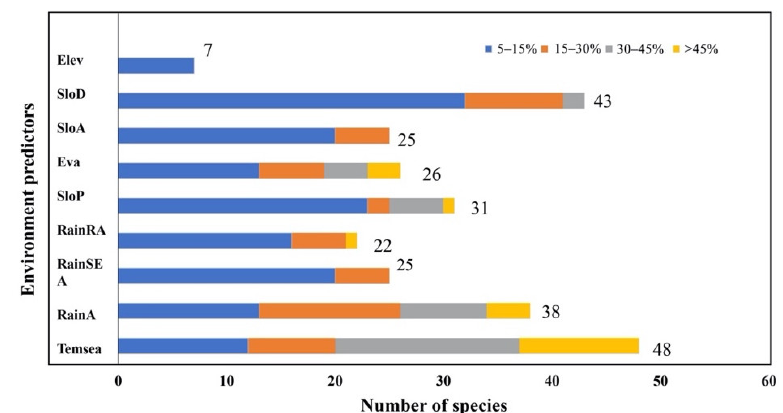
Figure 3. The frequencies of each environmental predictor and their contribution to the models of 60 main species in the Yanhe River catchment. The variable contributions were assessed using permutation importance in the MaxEnt output.